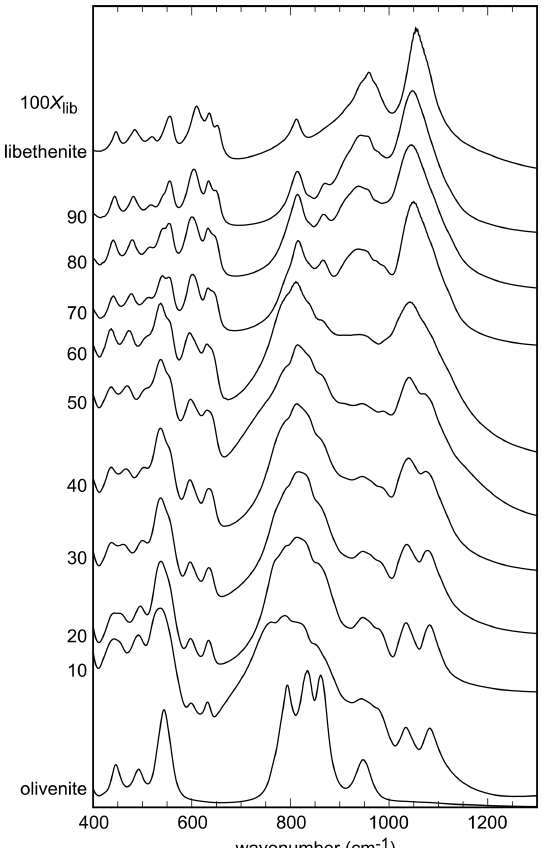
Figure 2. FTIR spectra of the synthetic members of the olivenite– libethenite solid solution. For the assignment of the bands, see the text. For clarity, the spectra were offset vertically.